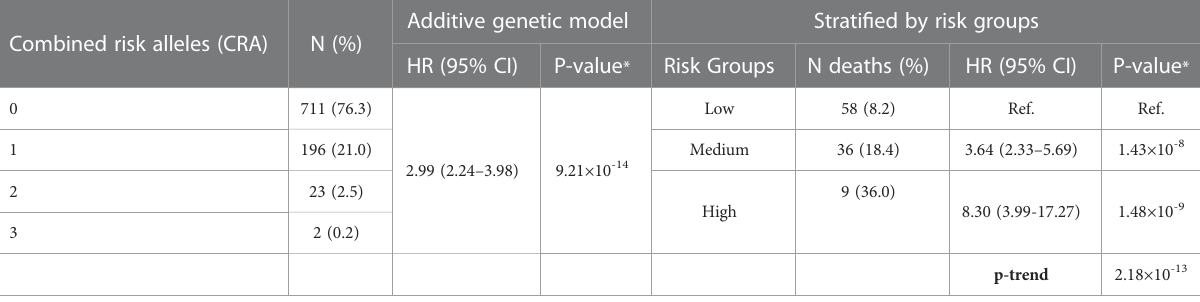
combinedeffectonOSwithlowriskgroupasreference.IndividualswiththehighestnumberofCRAhasthehighestriskofdeathasre fl ectedbybothpercentage ofdeathandHRinthe high risk group compared to medium and low risk. P-trend: p-value of trending signi fi cance assuming the three risk groups as continuous